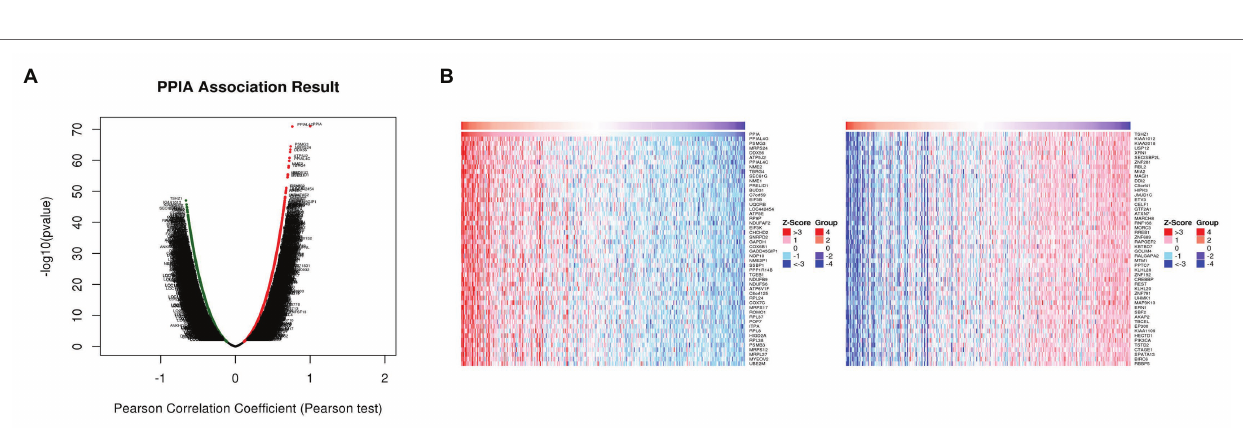
FIGURE 5 | Differentially expressed genes related to PPIA in HCC. (A) The correlation between PPIA and the differentially expressed genes in HCC analyzed using Pearson test. The red dots indicate positively related genes, and the green dots indicate negatively related genes. (B) Heat maps showing genes (top 50) that are positively correlated (left) and negatively correlated (right) with PPIA in HCC. PPIA, peptidylprolyl isomerase A; HCC, hepatocellular